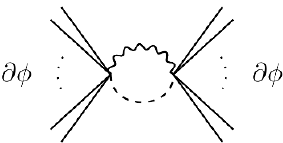
Figure 2 . One-loop diagram with a single internal graviton line that potentially gives large quan- tum corrections to the operator ( @(cid:30) ) 2 n . Again the internal dashed line represents the scalar legs with more than one